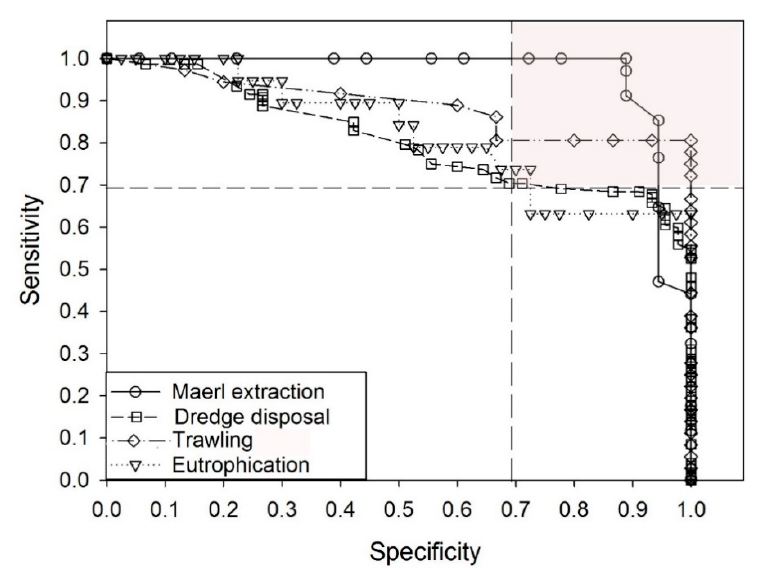
Figure 6. ROC curves for the four case studies. Sensitivity and specificity were computed with increasing cut-off of GPBI between 0 and 1 by 0.01. The “real” impact of stations was based on (1) distance to maerl extraction by Telemac-2D hydro-sedimentary model, (2) dredged sediment volume (zero vs. < zero), (3) fishing pressure zero in unfished area vs. > zero in fished areas, and (4) O2 concentration (average concentration less or greater than 2 mL L –1 the year before sampling). For further details, please see Section 2.